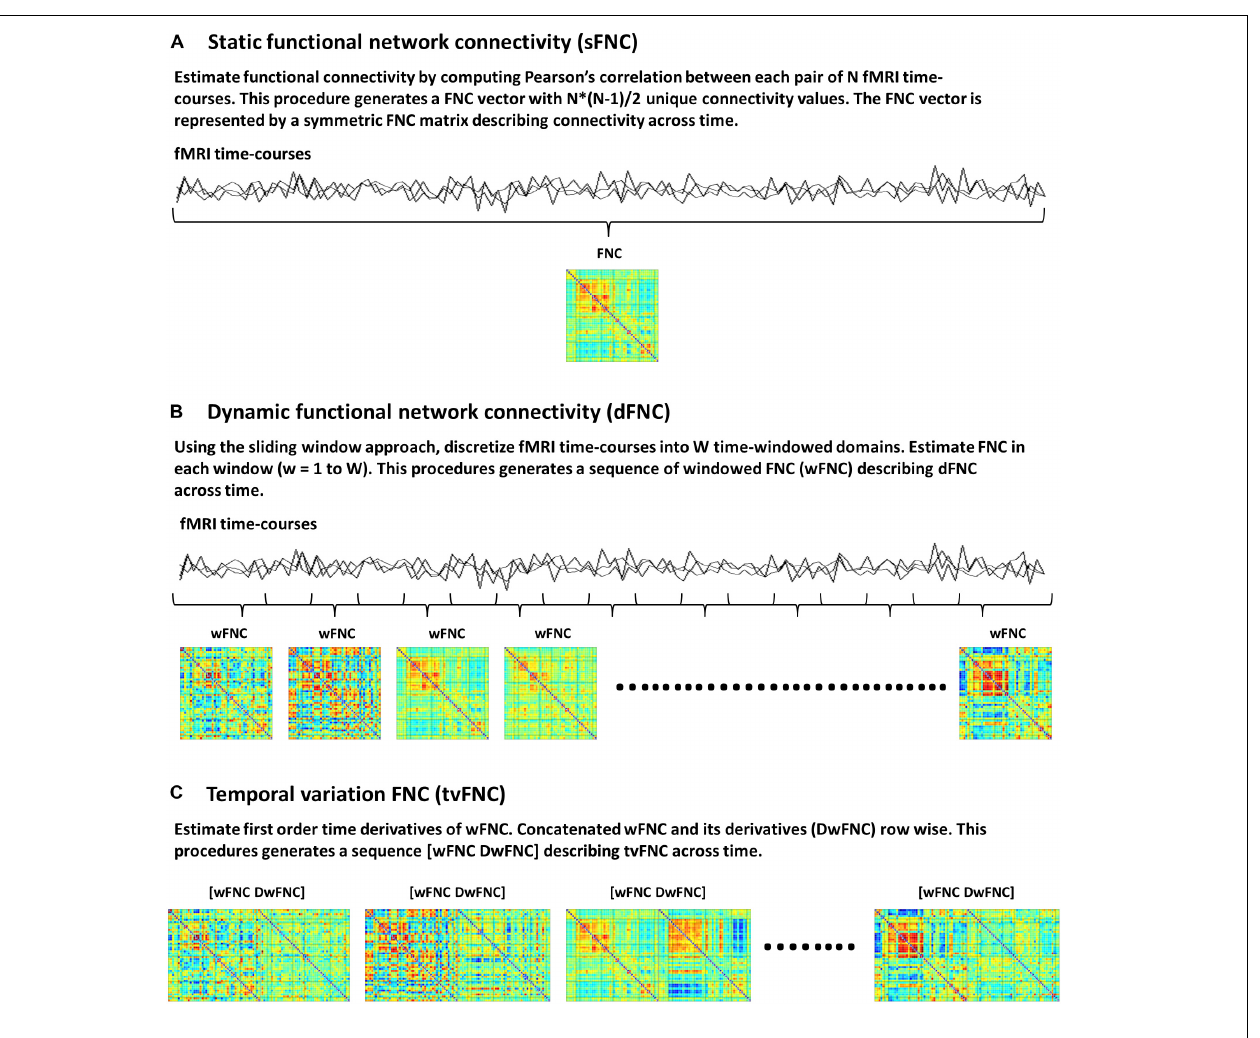
FIGURE 1 | Functional network connectivity (FNC) subject’s data, (A) Static FNC, (B) Dynamic FNC, and (C) Temporal variation of